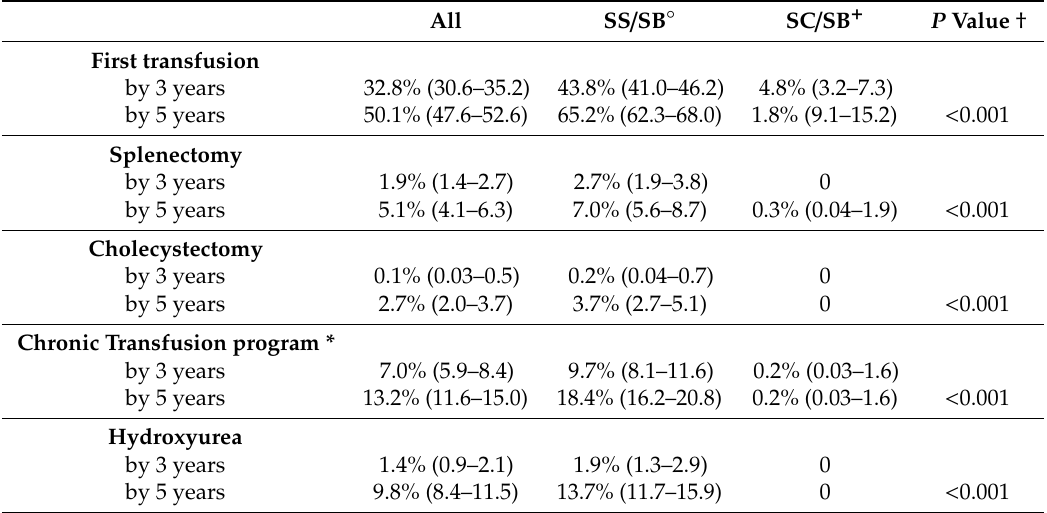
Table 4. Proportion of therapeutic intervention or disease modifying therapy initiation by three years of age and probability by five years of